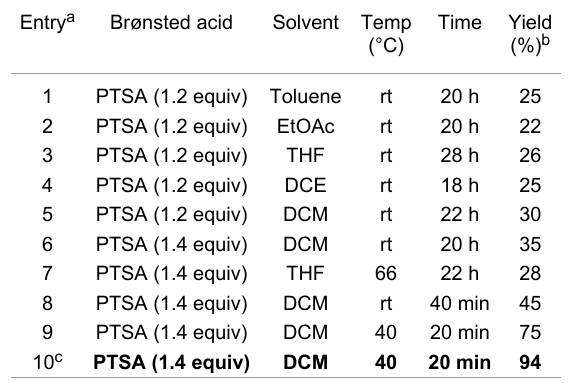
Table 1: Optimization of reaction